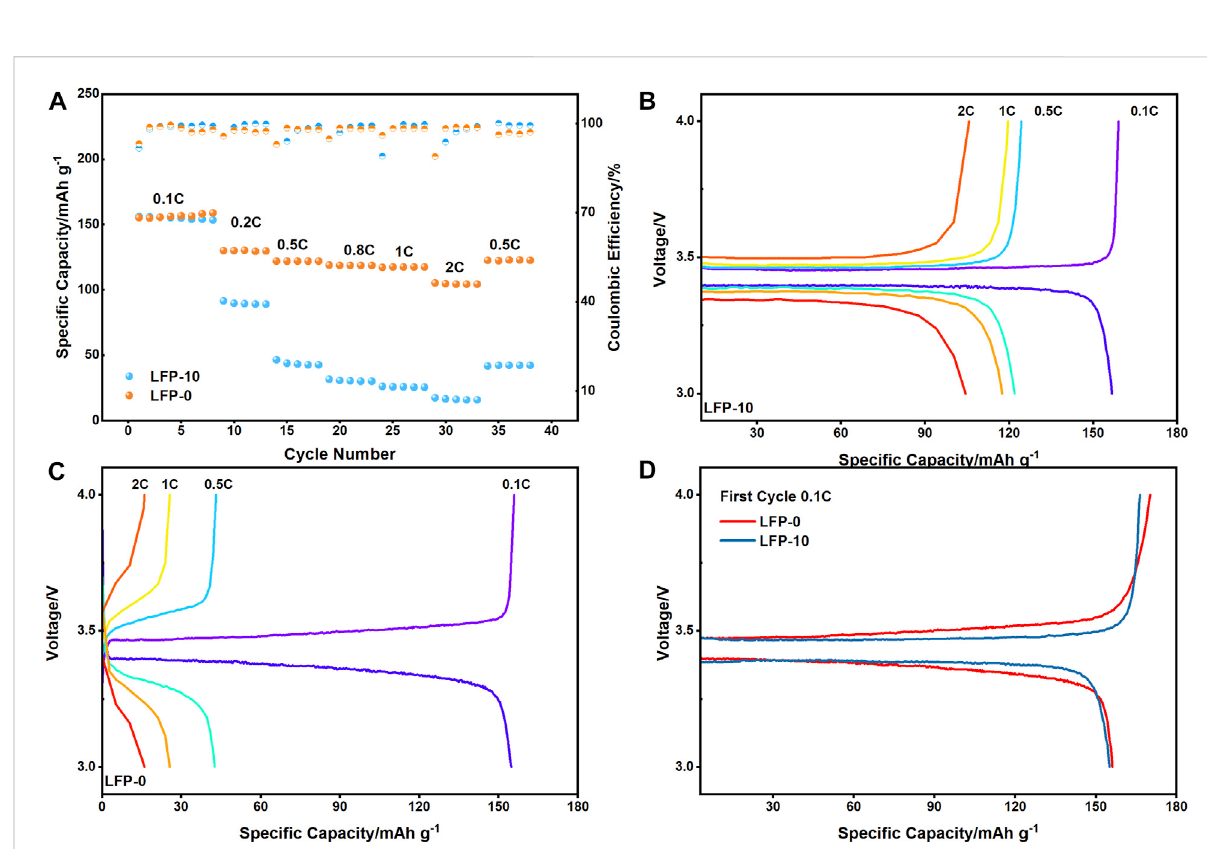
FIGURE 10 (A) RateperformanceofASSLBat60 ° C; (B,C) charge-dischargecurveofLFP-10andLFP-0atdifferentrate; (D) charge-discharge curveofLFP- 10 and LFP-0 at fi rst cycle,